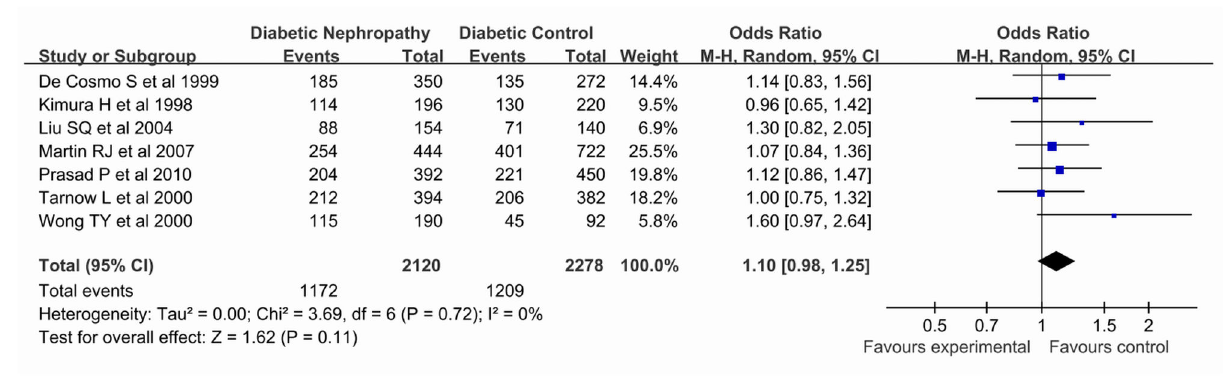
Figure 2. Pooled ORs for the association between the PAI-1 -675 4G/5G polymorphism (4G vs. 5G) and susceptibility to diabetic nephropathy. The area of the squares reflects the study-specific weight. The diamond shows the summary fixed-effects OR estimate from 7 studies.